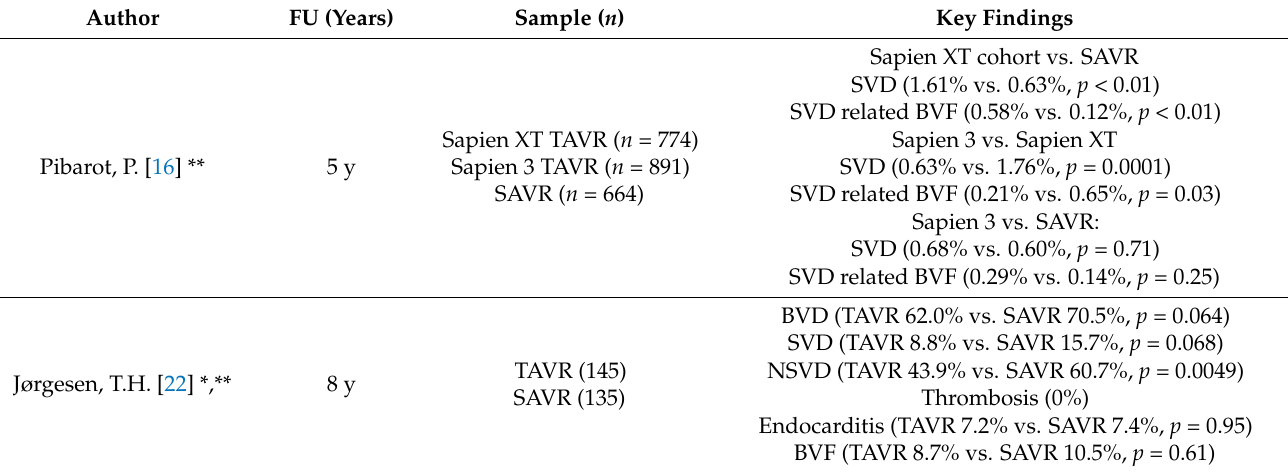
Table 1. Summary of studies reporting data on TAVR long-term